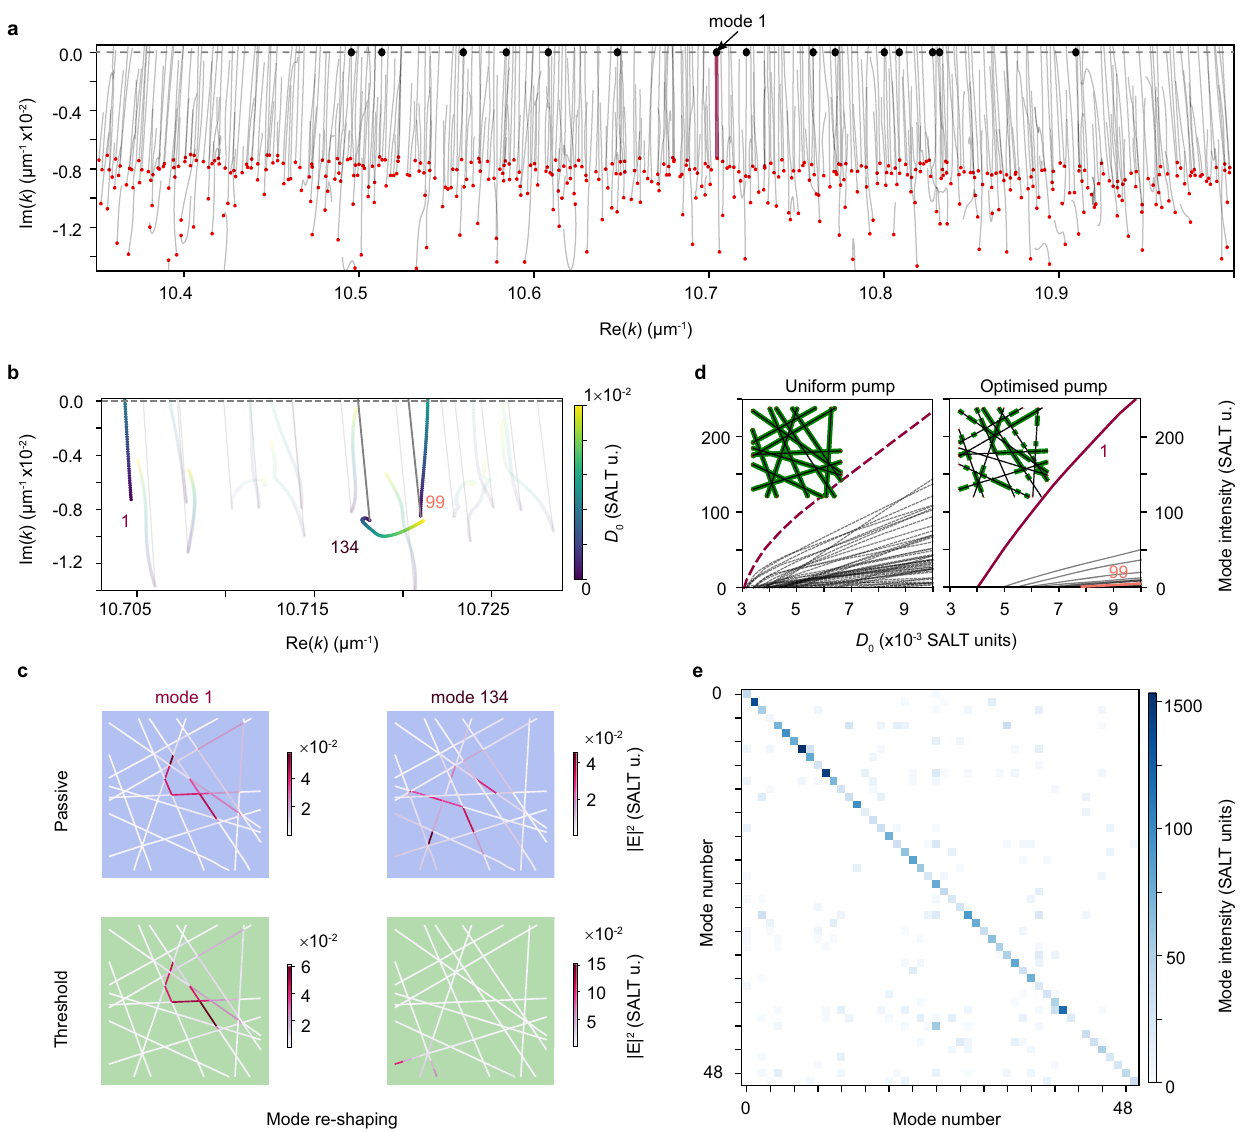
Fig. 2 | Achieving single mode lasing through non-uniform pumping (theory). a-b NetSALT calculations for lasing on a Buffon graph with non-uniform pumping indicatevariousprocessesformodeselection. a Modetrajectoriesinthecomplex k plane (shown over large Re( k ) range, with red dots identifying the passive modes andblackdotsidentifyingthemodesthatlase.Thenon-uniformpumppro fi leused toobtainthesetrajectoriesisshownin d ,right-handpanelinset. b Zoomof a overa small range of wavelengths with trajectories shown in colour, where the colour scale indicates the pump strength. Three modes (1, 99, and 134) are highlighted to exemplify the different processes involved in mode selection. Mode trajectories with uniform pumping are shown by solid grey lines. c Example mode pro fi les for